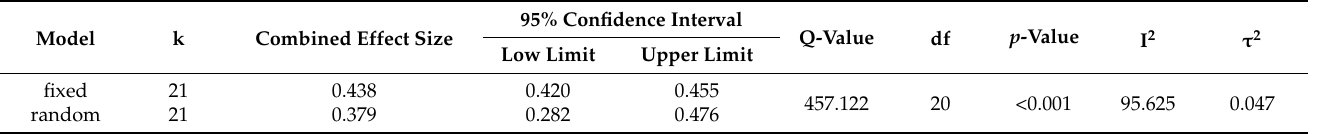
Table 4. Total sample heterogeneity test.